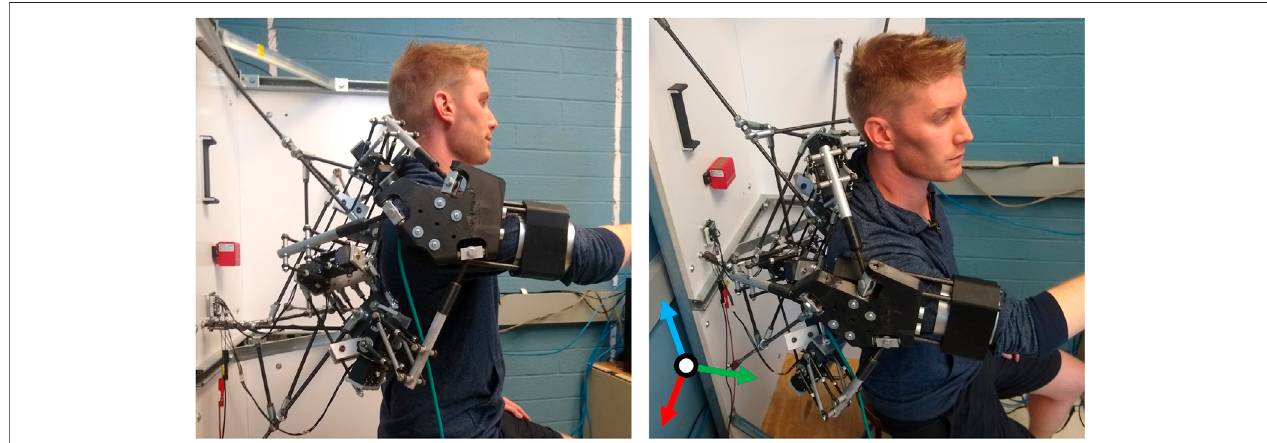
FIGURE 3 | 4B-SPM shoulder exoskeleton prototype mounted to a stationary platform with a human subject in the seated position. The subject is coupled to the device through theuse ofanupper arm cuff. Tomaintain goodcontactbetweenthe subjectand device,ablood pressure cuffisused at thecontact point. The pitch, roll and yaw axes are represented by the orthogonal red, green and blue axes, respectively.